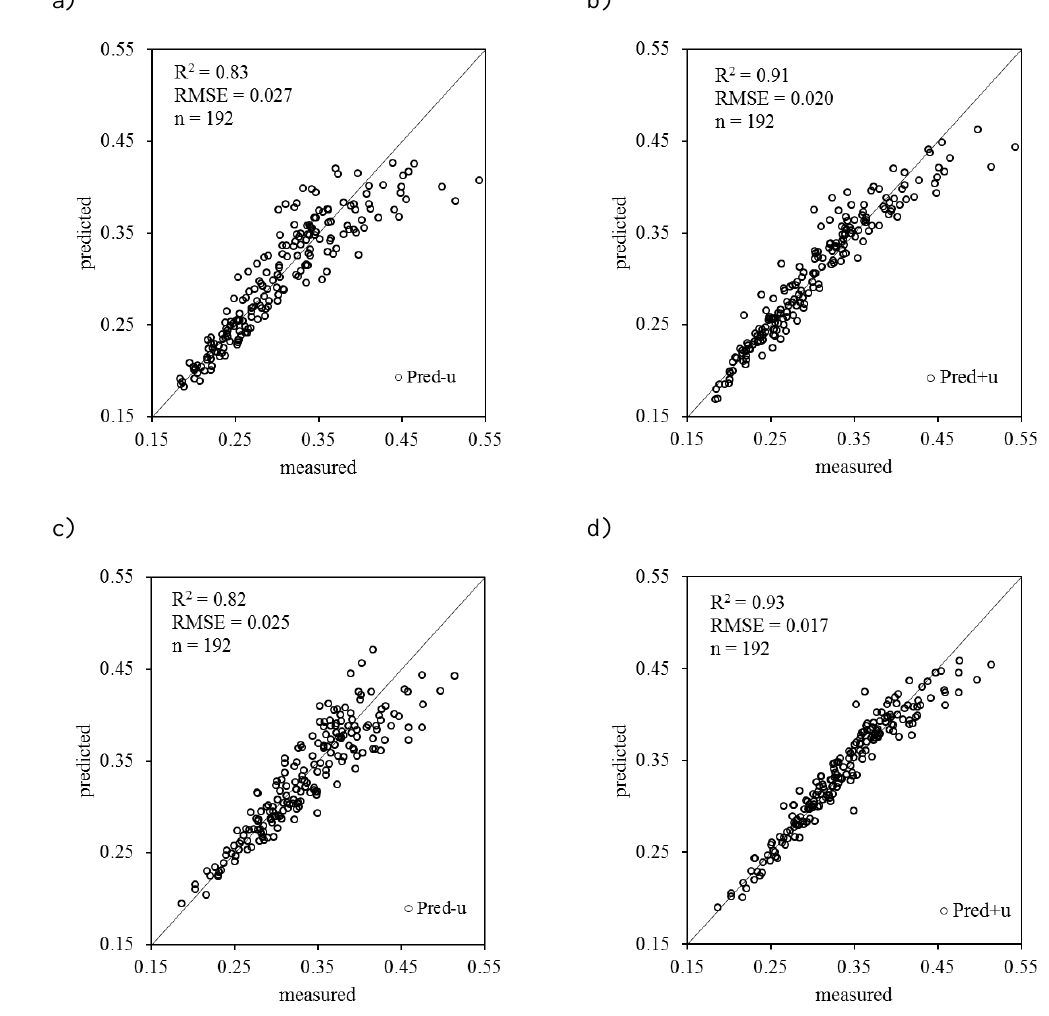
Figure 3. Goodness of fit of the NLM model used to predict soil water retention capacity, summarised via correlation coefficient ( R 2 ) and root mean square error (RMSE). Agreement between measured and predicted moisture values (a, c) ; agreement between measured and predicted moisture values including the random effect u in the model (b, d) . Data measured in 2 years and two soil layers: 5–10cm (a, b) and 15–20cm (c, d)